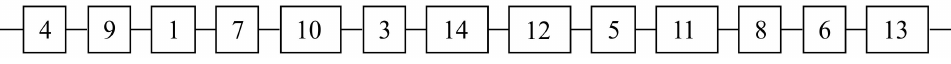
Figure 5. The series system representing the damaged precast concrete frame.